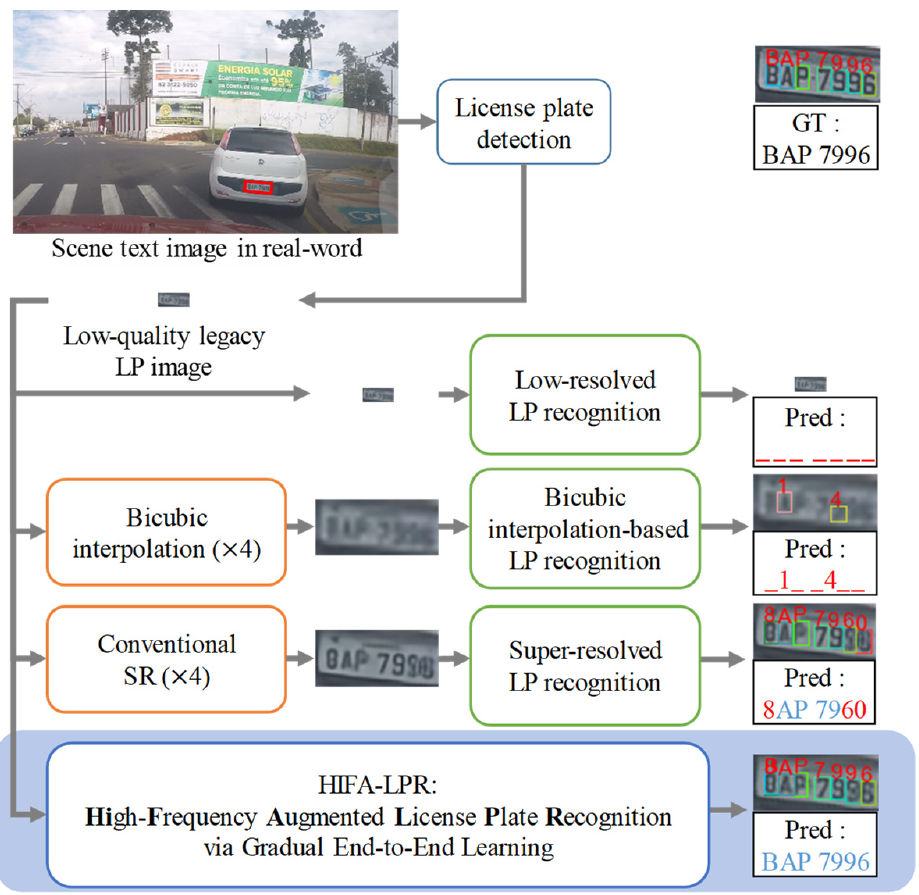
Figure 1. Examples of LP recognition approaches in a real-world scenario. Our proposed HIFA-LPR model outperforms conventional approaches. “_” denotes a missing character recognition. Red character denotes incorrect prediction. Blue character denotes correct prediction. “GT” denotes ground truth. “Pred” denotes the prediction result.